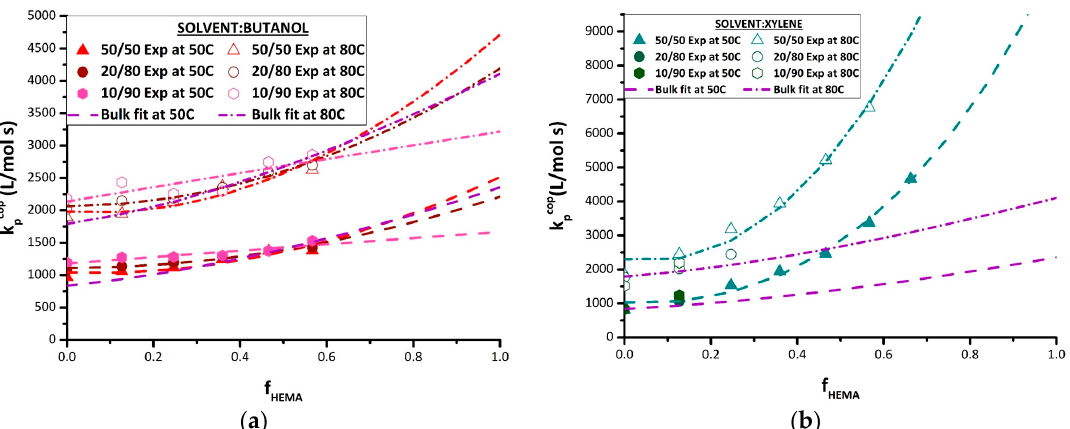
Figure 7. Experimental results (points) for BMA/HEMA k p,cop determined at 50 and 80 °C by PLP-SEC experimentation in ( a ) BUOH and ( b ) xylene at different monomer/solvent volume ratios (see legends). Terminal fits represented by the dotted lines, with best fit values of k p,BMA and k p,HEMA summarized in Table 4. The best-fit lines representing the bulk system are taken from Figure